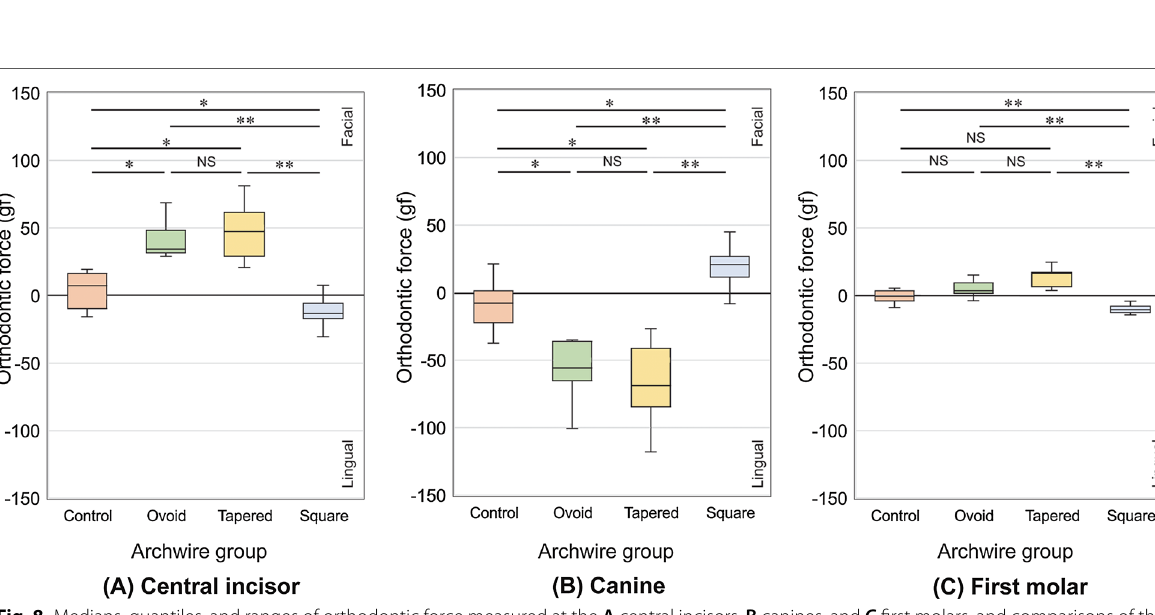
Fig. 8 Medians, quantiles, and ranges of orthodontic force measured at the A central incisors, B canines, and C first molars, and comparisons of the four arch form groups by Kruskal–Wallis and post hoc multiple tests with correction for the false discovery rate. * P < .05, ** P < .01, NS; Not significant (Facial: positive, Lingual: